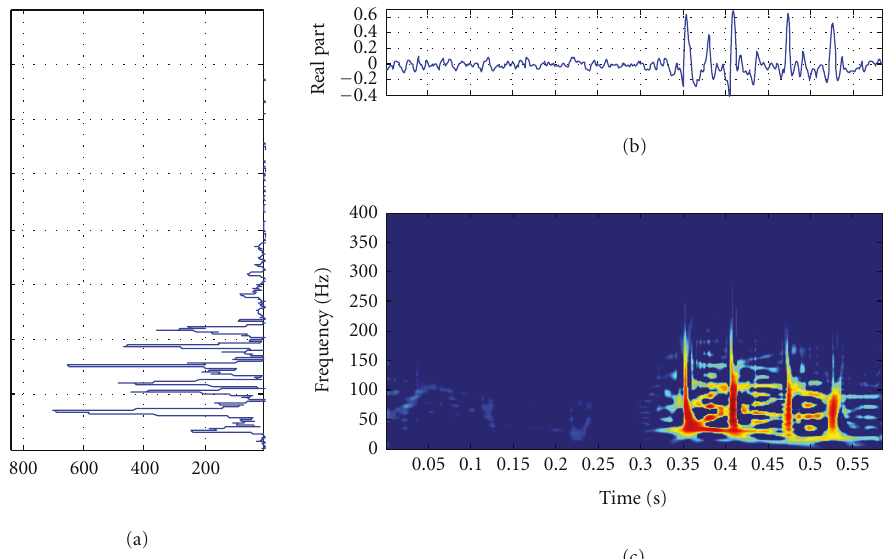
Figure 10: The (a) power spectral density, (b) time-domain waveform, (c) time-frequency visualization, and (d) energy peak for subject 003 walk four S 3